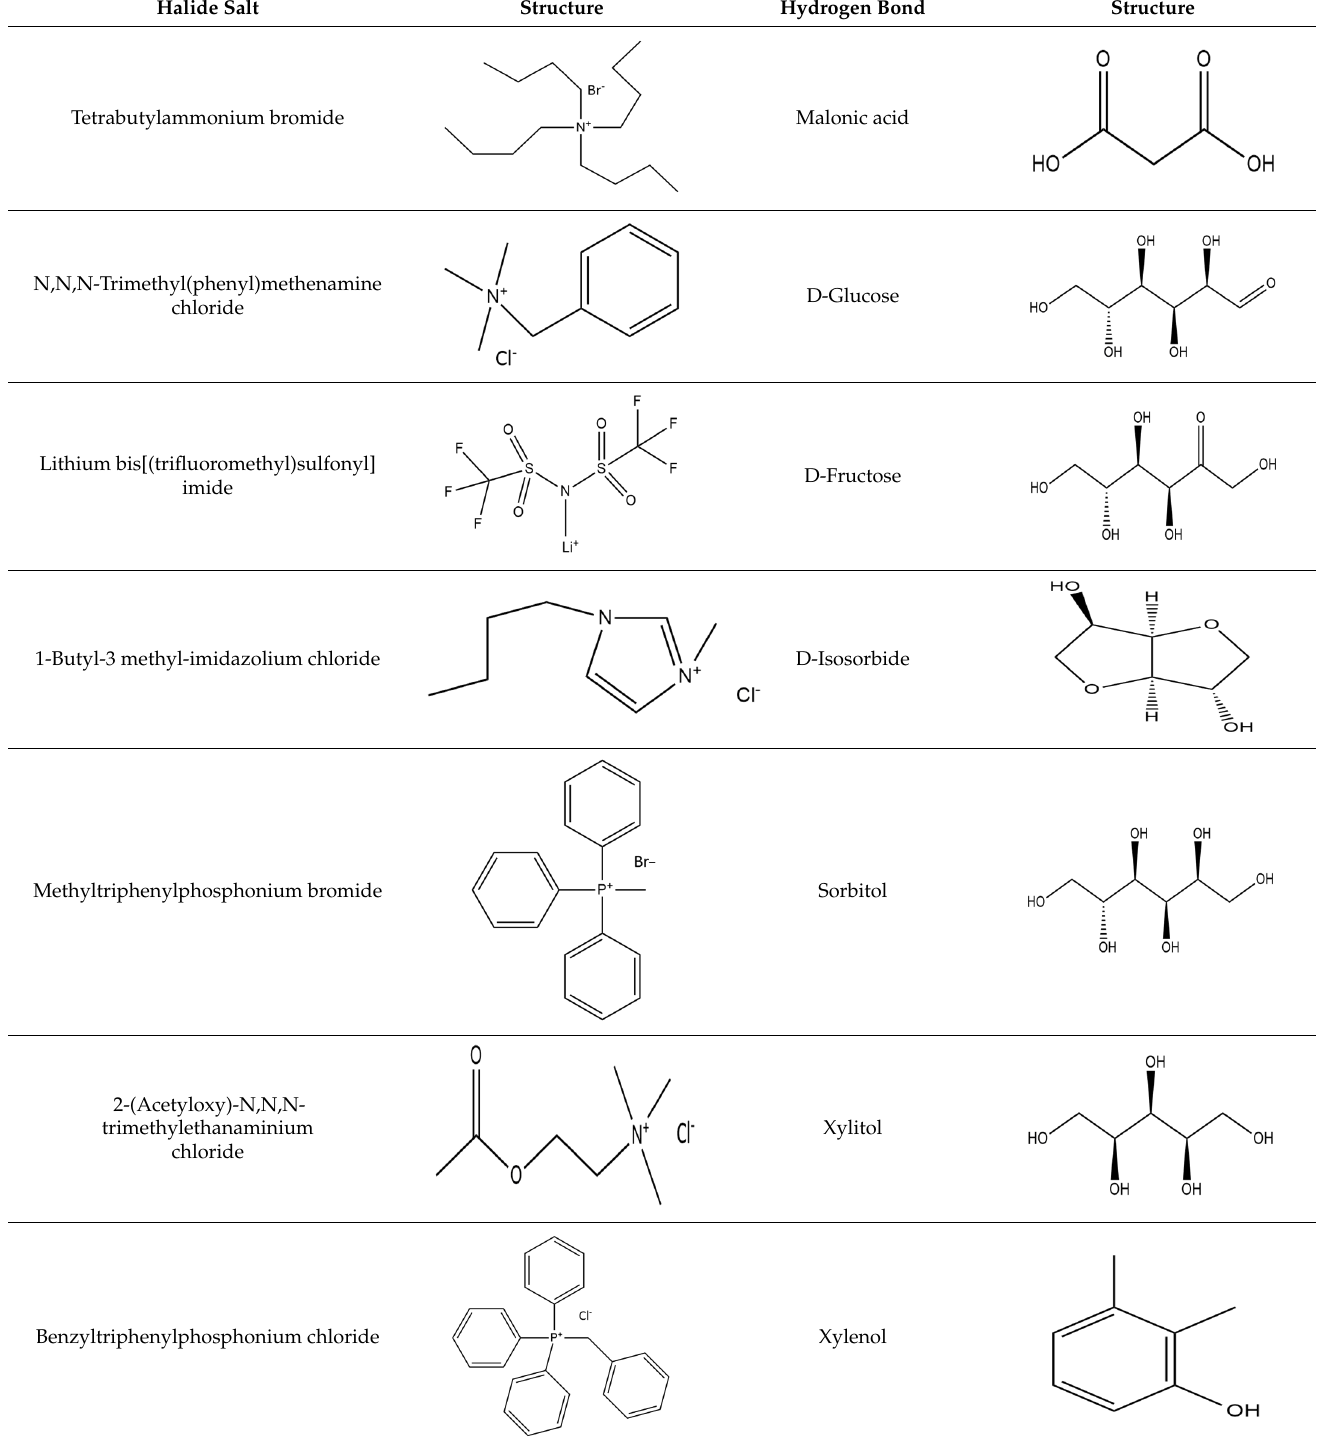
Table 4. Cont. Structure Hydrogen Bond